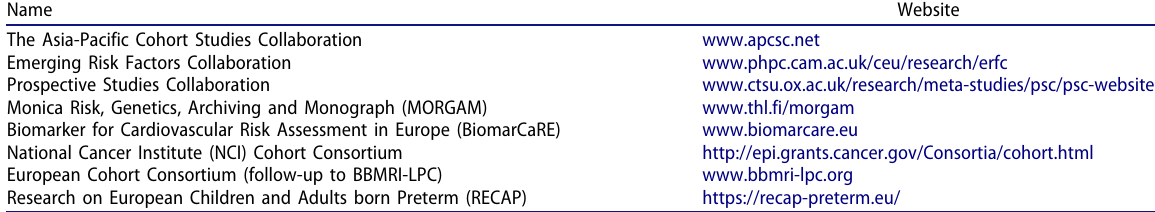
Table 3. International infrastructures with which collaboration may be